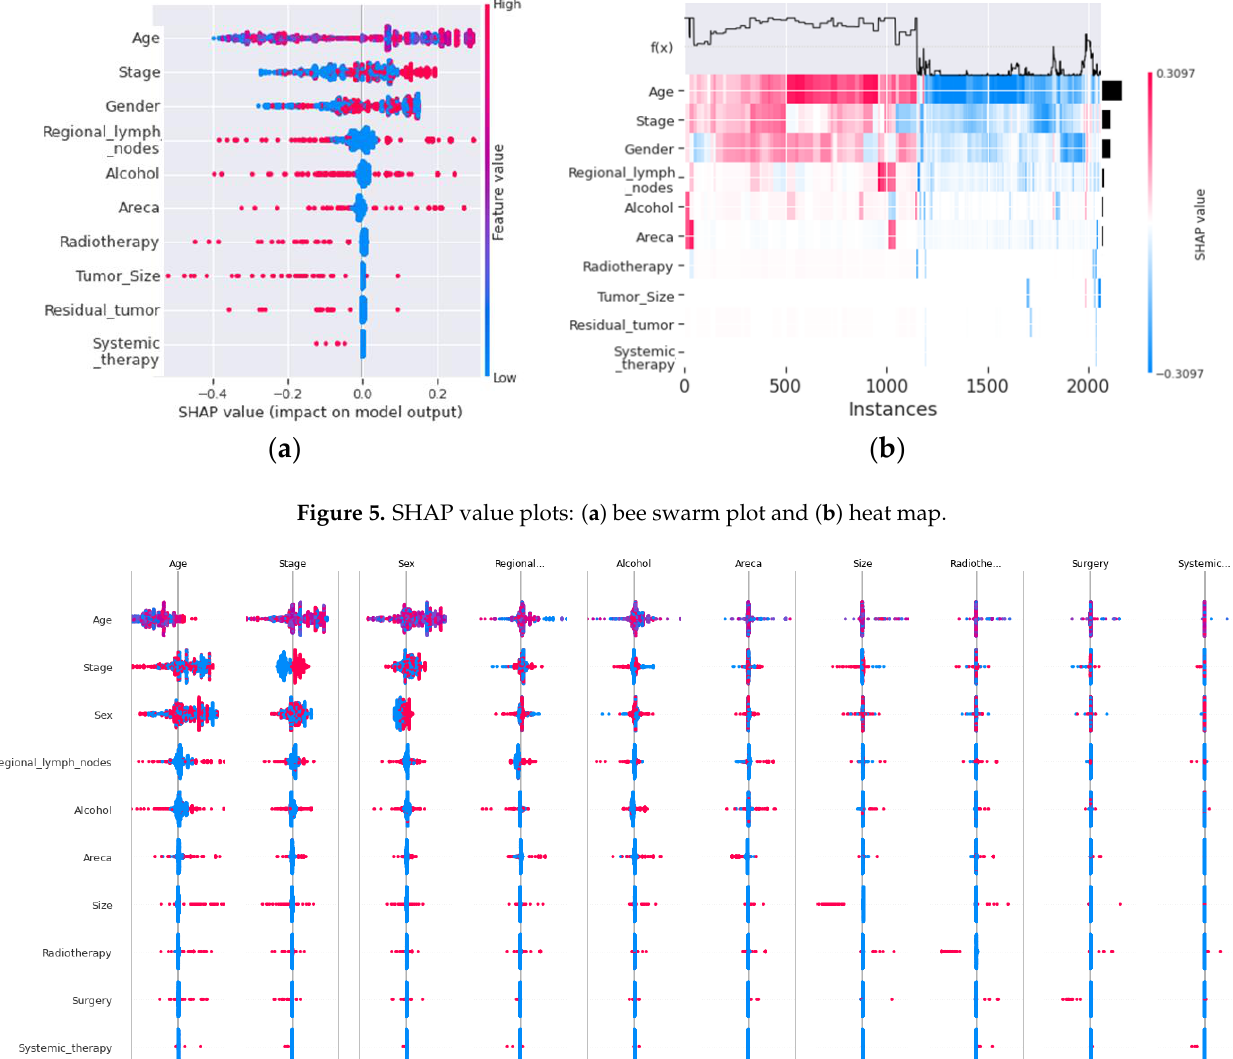
Figure 6. Dependence plot matrix of the SHAP interaction values.